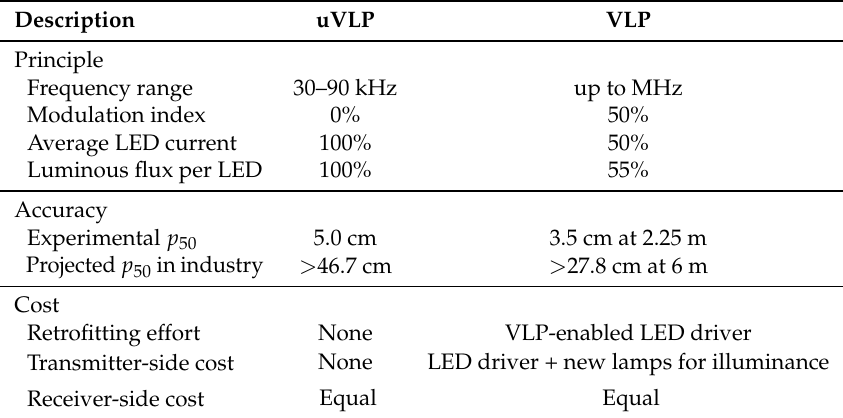
Table 1. Comparison of uVLP and ‘regular’